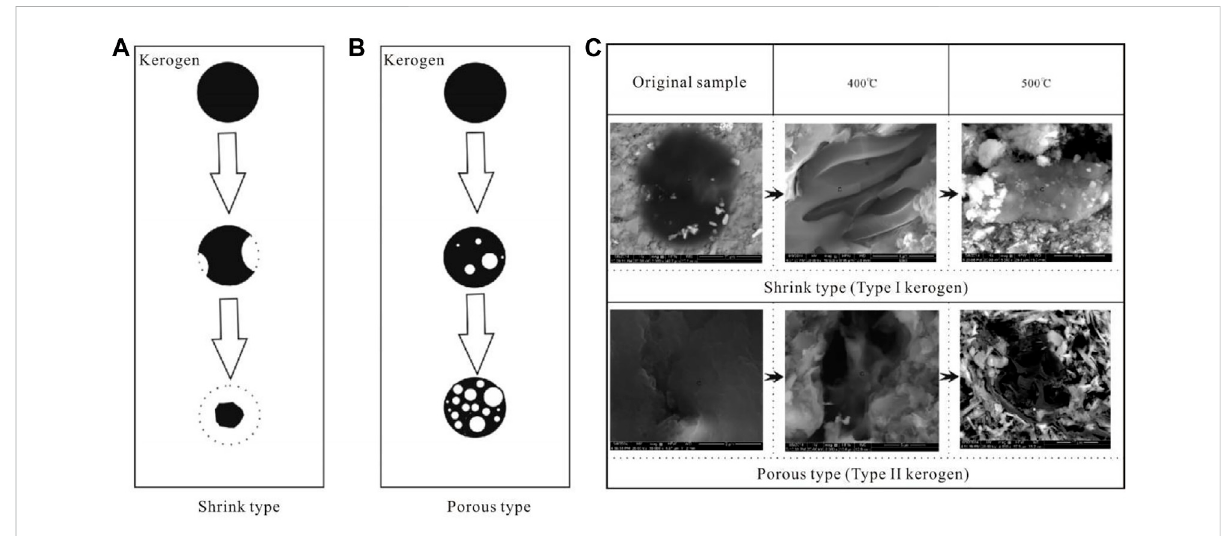
FIGURE 7 Evolution of organic matter morphology and organic matter pores (modi fi ed after Dong et al., 2015). Notes: (A) shrinkable organic matter; (B) porous organic matter; (C) thermal evolution mode of organic